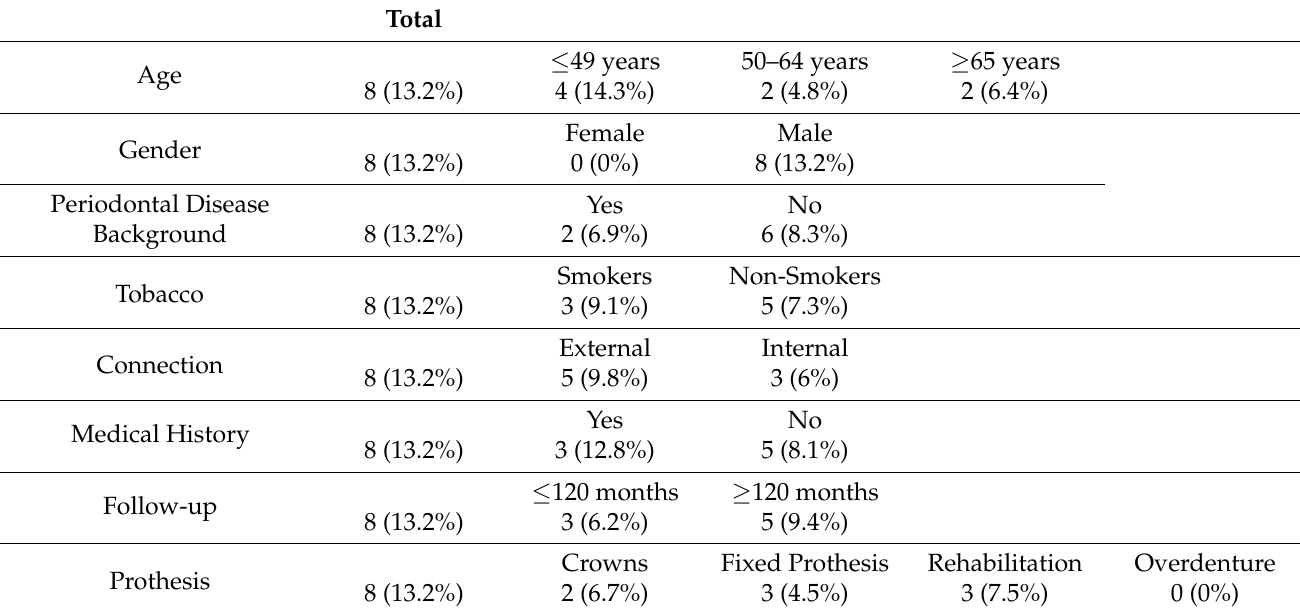
Table 4. Distribution of patients according to implant loss.